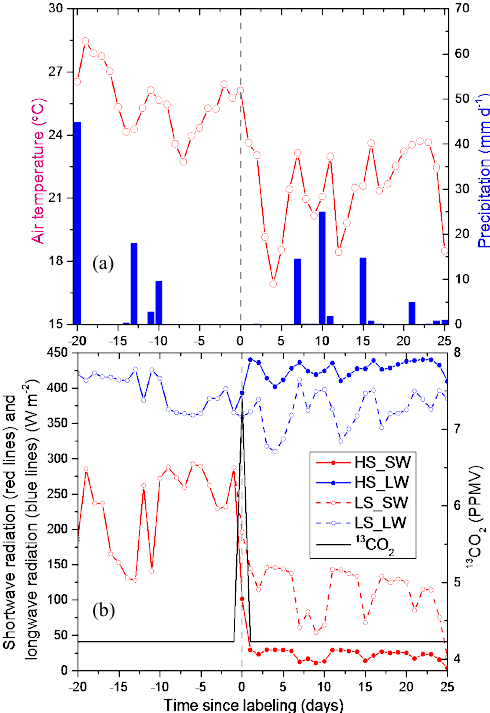
Figure 2. (a) Daily air temperature ( ◦ C) and precipitation (mmd − 1 ) for the pretreatment and treatment of light shade (LS) and heavy shade (HS) (day − 20 to 25); (b) change in daily atmospheric long- wave radiation (LW; Wm − 2 ), shortwave radiation (SW; Wm − 2 ), and 13 CO 2 (PPMV) prior to and after exposure to shade treatments. Dashed gray line represents the starting day of the